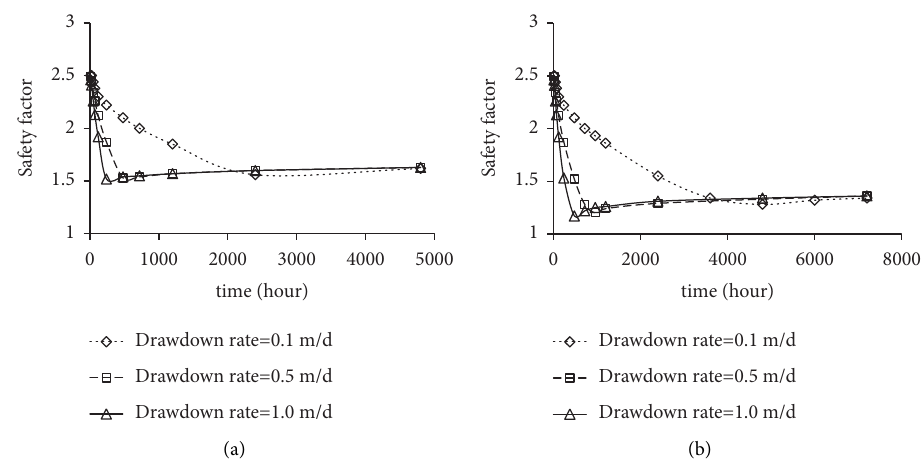
Figure 7: The stability variation versus time in the SUCDs (with the same slope gradients): (a) r � 0 . 415 and (b) r � 0 . 830.